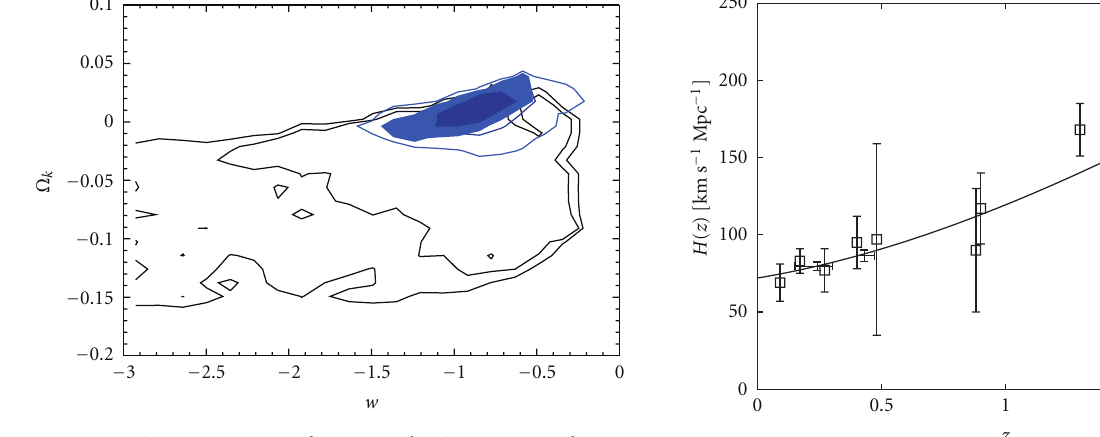
Figure 3: Joint constraint on the energy density corresponding to the spatial curvature, Ω k , and the dark energy equation of state parameter, w , by Stern et al. [26]. The large, irregular regions bounded by dark contours were from 5-year WMAP alone. The blue contours were obtained by adding H 0 constraints. Filled regions were obtained by further adding H ( z ) data. The application of H ( z ) data helps with breaking the degeneracy between Ω k and w .